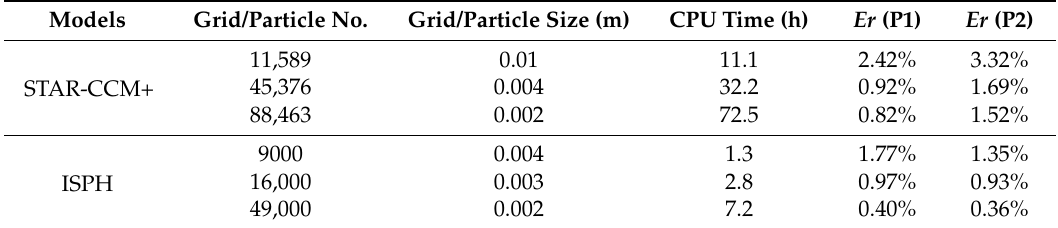
Table 1. Numerical error and CPU analyses of ISPH and